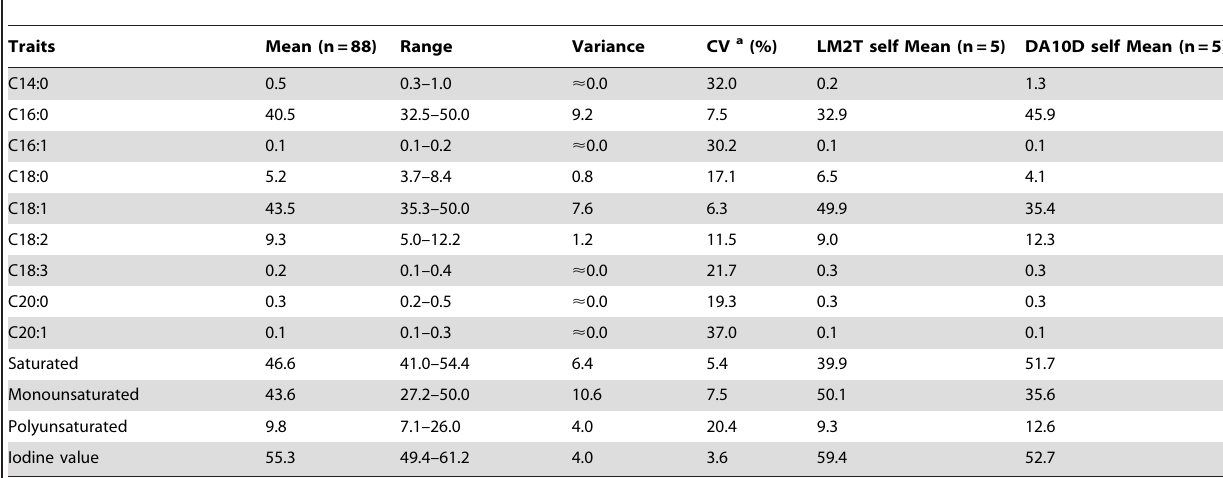
Table 1. Means, ranges, variances, and coefficients of variation (CVs) for palm oil fatty acid composition and iodine value in the E. guineensis intraspecific cross LM2T x DA10D.